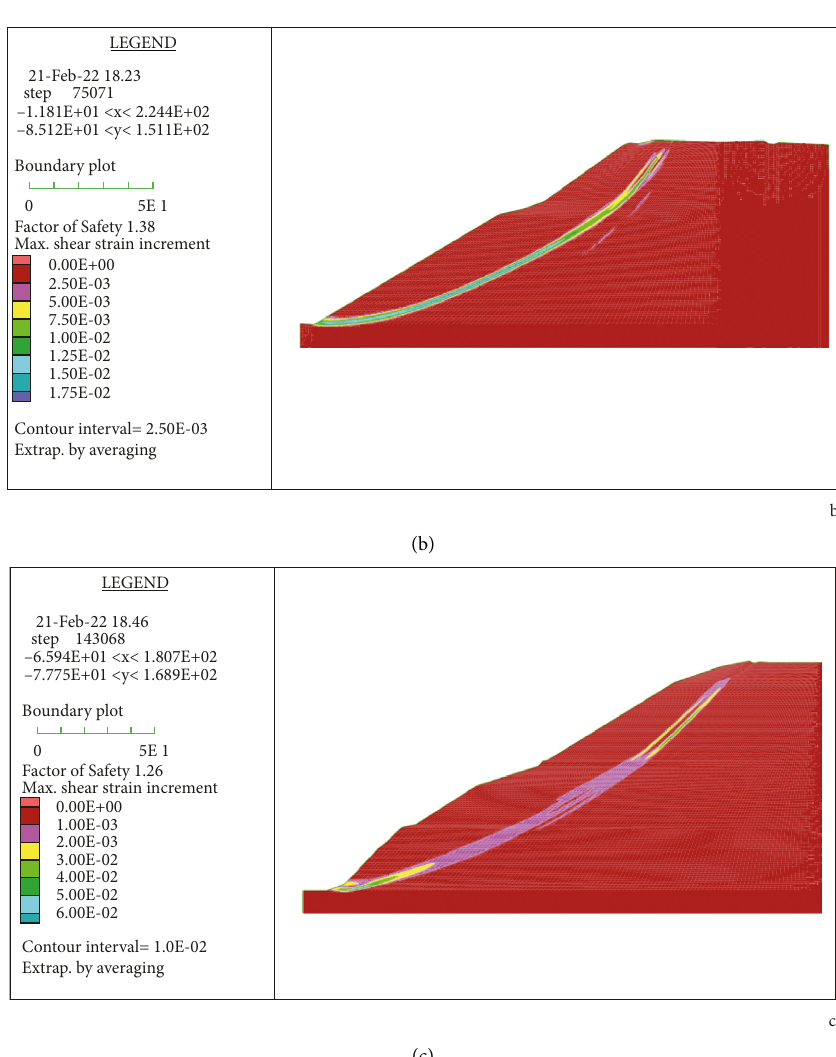
Figure 10: (a–c) circular failure profiles of sections 1, 2, and 3.